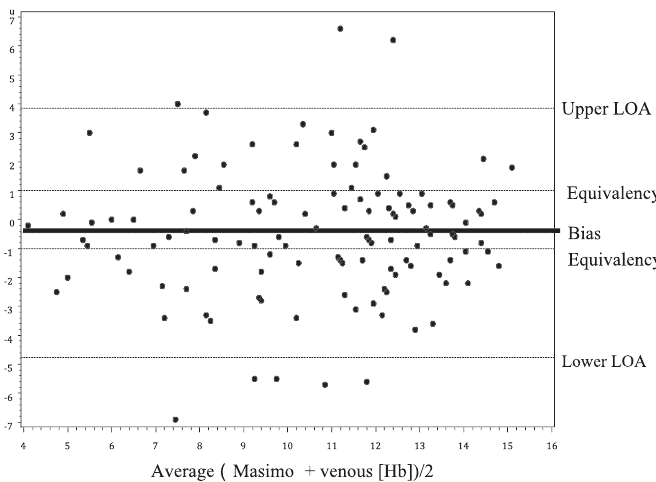
Figure 2. Bland-Altman plot of the difference between Masimo and venous hemoglobin (Hb) measurements. Dark line represents Masimo bias. Inner dashed line represents area of equivalency, which is 6 1 g/dL of Hb. Outer dashed line represents limits of agreement. LOA , limit of